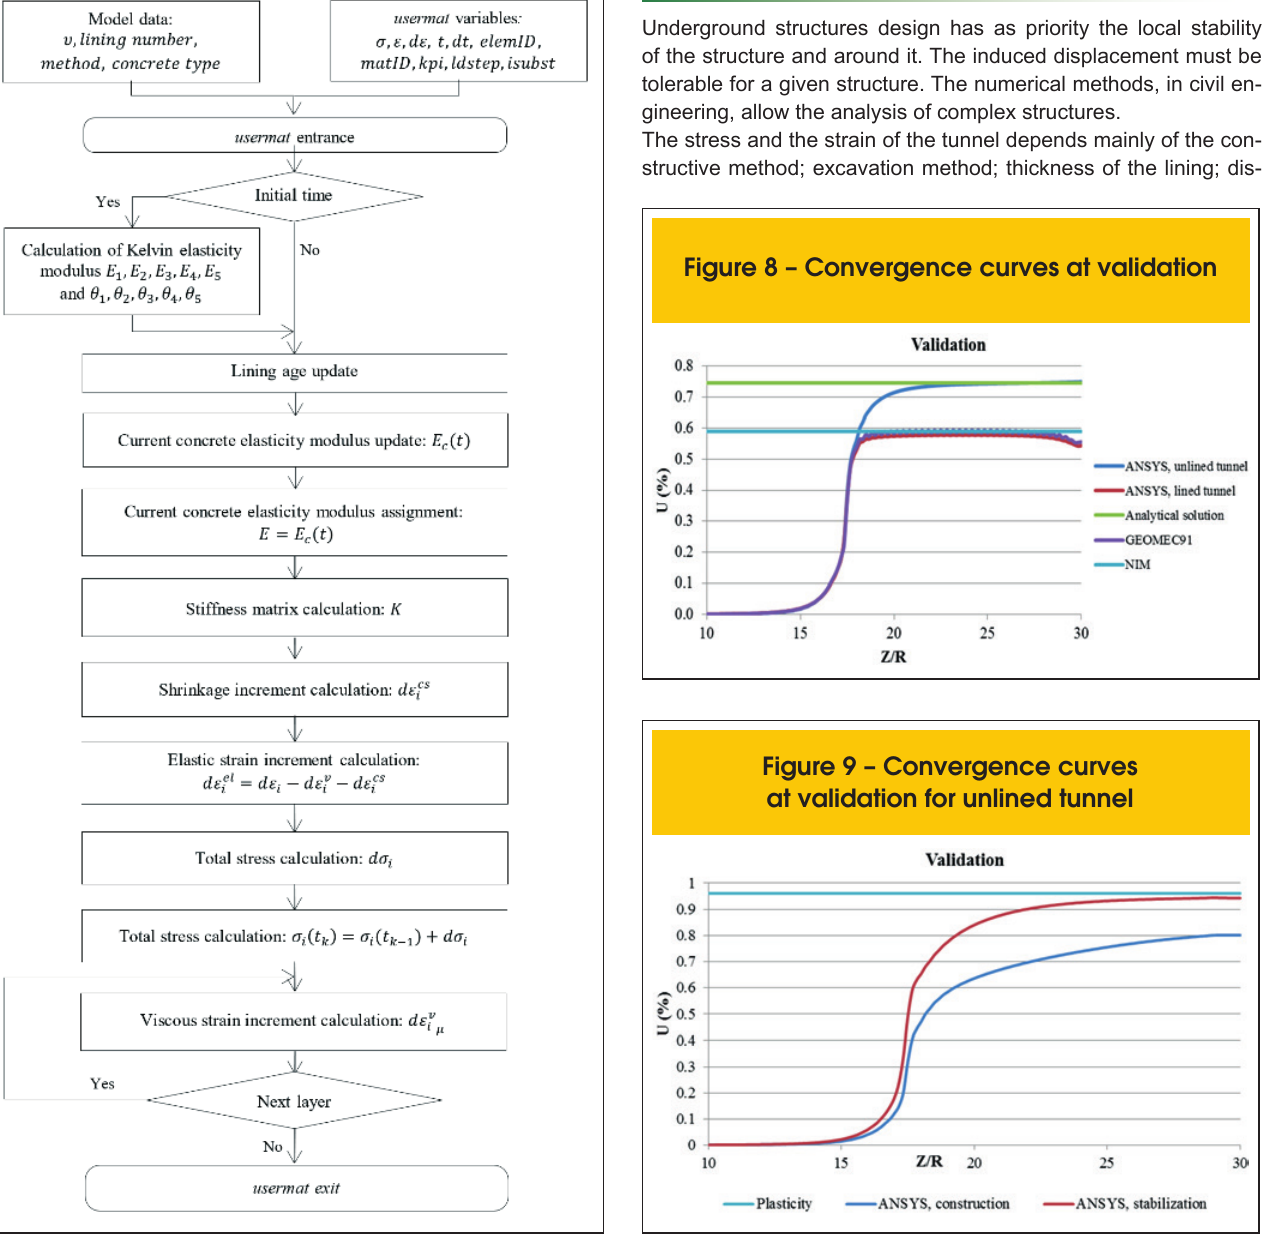
Figure 7 – Usermat flowchart for Kelvin chain model